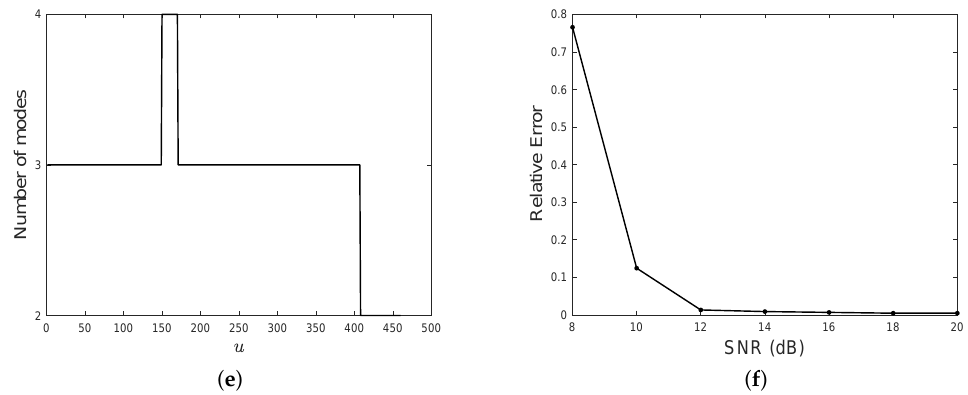
Figure 19. ( a ) AM–FM signal composed of four components embedded with AWG noise, SNR = 15 dB. ( b ) Spectrogram of ( a ), s = 46. ( c ) Optimal threshold provided by MDL functional minimization, according to Equation (18). ( d ) Binary map derived from ( b ). ( e ) Estimated number of modes. ( f ) Relative counting error against SNR.